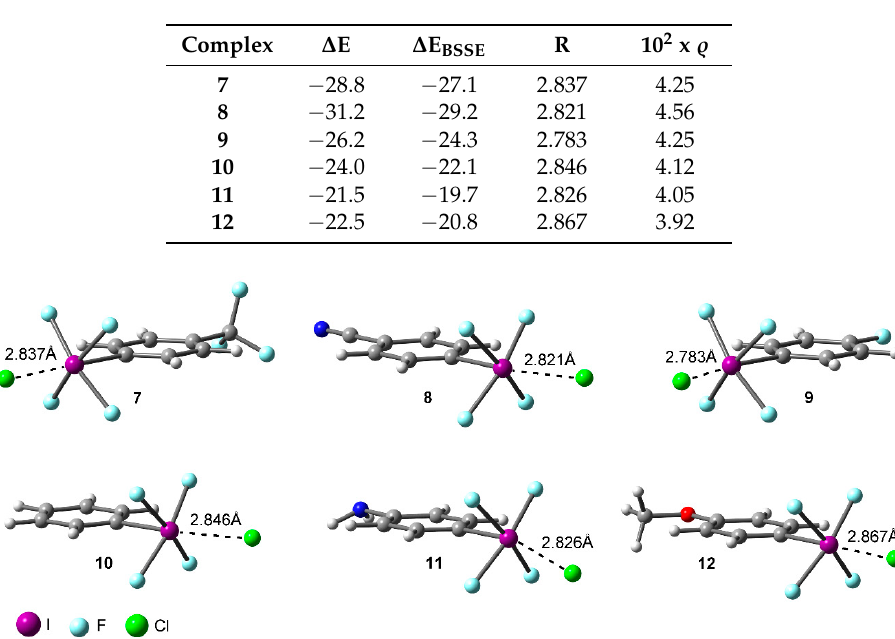
Figure 3. RI-MP2/def2-TZVPD optimized geometries of Complexes 7 to 12 .